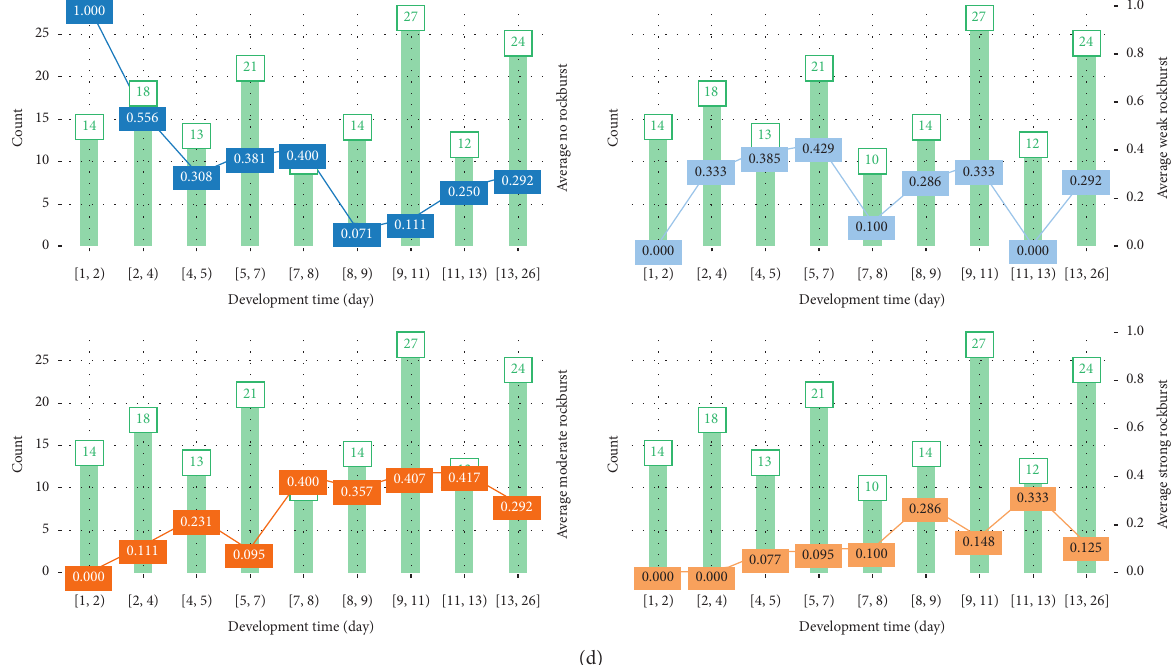
Figure 9: Impact of MS parameters on rockburst. (a) Number of MS events. (b) MS energy. (c) MS apparent volume. (d) Development time.